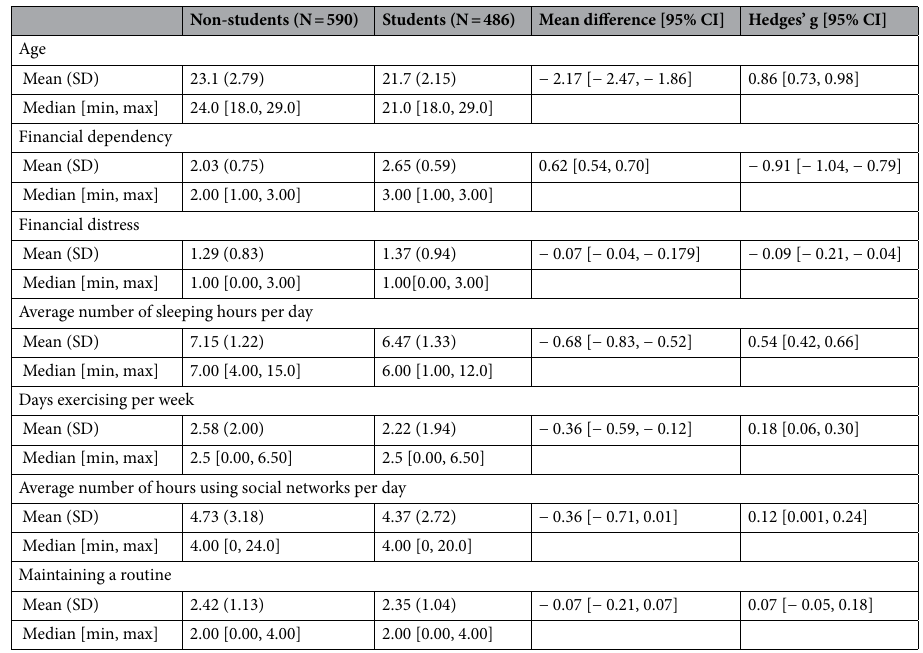
Table 4. Descriptive statistics, mean differences and effect sizes (Hedges’ g) of the numeric predictors by group.